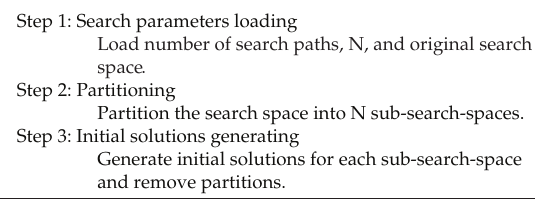
Figure 3: The PM procedures.